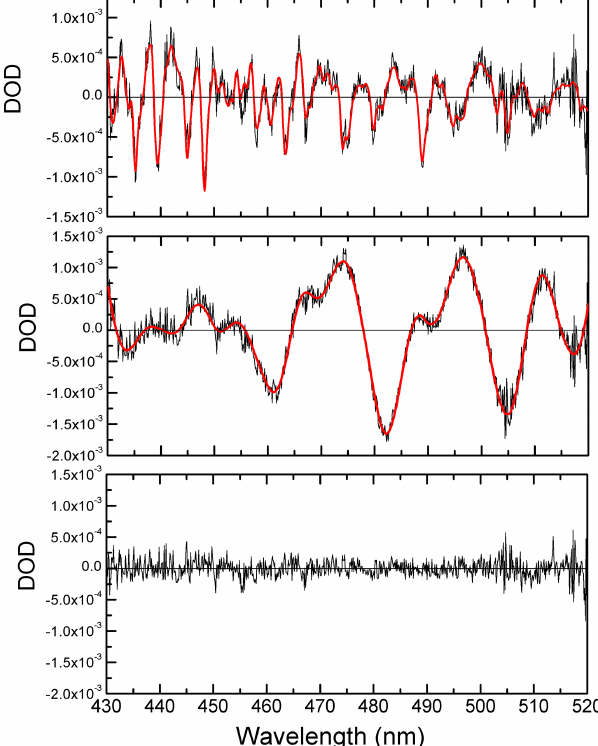
Figure 6. Example of a horizontal DOAS fit using a zenith spectrum as a reference. Values of 4.0 × 10 15 and 8.7 × 10 18 moleculescm − 2 for NO 2 (upper panel) and O 3 (middle panel), respectively, were obtained during this cycle. The residual is shown in the lower